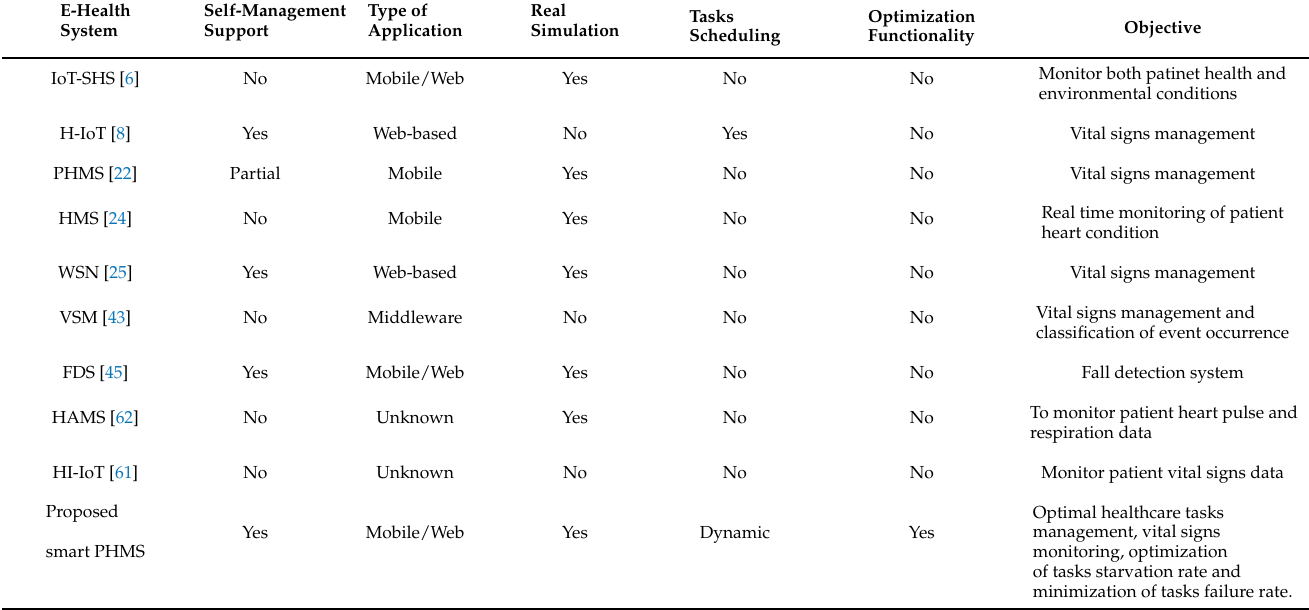
Table 7. Comparative analysis of the proposed smart PHMS with existing e-Heath